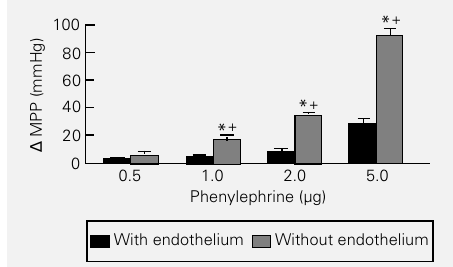
Figure 3 - Effects of increasing doses of phenylephrine (PE) on the increase in mean perfusion pressure (MPP) of the rat tail vascular bed before and after endothelial damage with air and CHAPS buffer. Preparations were perfused at a flow rate of 2.5 ml/min with Krebs solution containing 1.25 mM Ca 2+ . Each column represents the means ± SEM for N = 10. + P<0.01 for comparisons between PE ef- fects before and after endothe- lial damage (ANOVA). *P<0.01 compared to 0.5 µg PE (two- way ANOVA). The interaction between the two conditions was significant (P<0.0001), sug- gesting an enhancement of PE effects after endothelial dam-